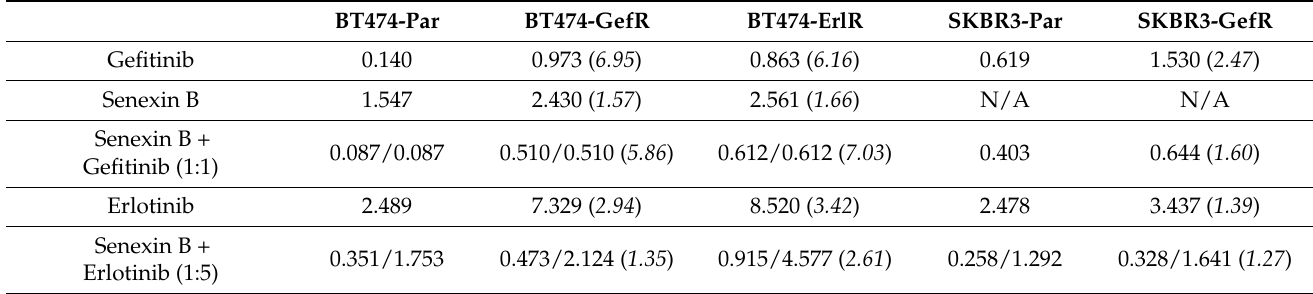
Figure 3. Effects of gefitinib and erlotinib alone and in combination with Senexin B in parental and gefitinib- or erlotinib- adapted BT474 cells. ( A – C ). Effects of 7-day treatment with gefitinib (GEF) and senexin B (SNXB), alone or in 1:1 combination, in parental ( A ), gefitinib-adapted ( B ), and erlotinib-adapted ( C ) BT474 cells. ( D – F ). Effects of 7-day treatment with erlotinib (ERLO) and senexin B, alone or in 5:1 combination, in parental ( D ), gefitinib-adapted ( E ), and erlotinib-adapted ( F ) BT474 cells. Data shown as mean ± SEM of six replicate measurements. Combination index (CI) values at IC50 concentrations are shown in lower left corner of each graph. Table 1. IC 50 values ( µ M) for parental and gefitinib- or erlotinib-adapted cell populations in 7-day growth inhibition assays shown in Figures 3 and 4. In case of drug combinations, IC 50 values are shown for each drug; fold change in IC 50 relative to parental cells shown in parentheses ( italicized ). IC50 values for senexin B in SKBR3 cells could not be determined due to the low extent of growth